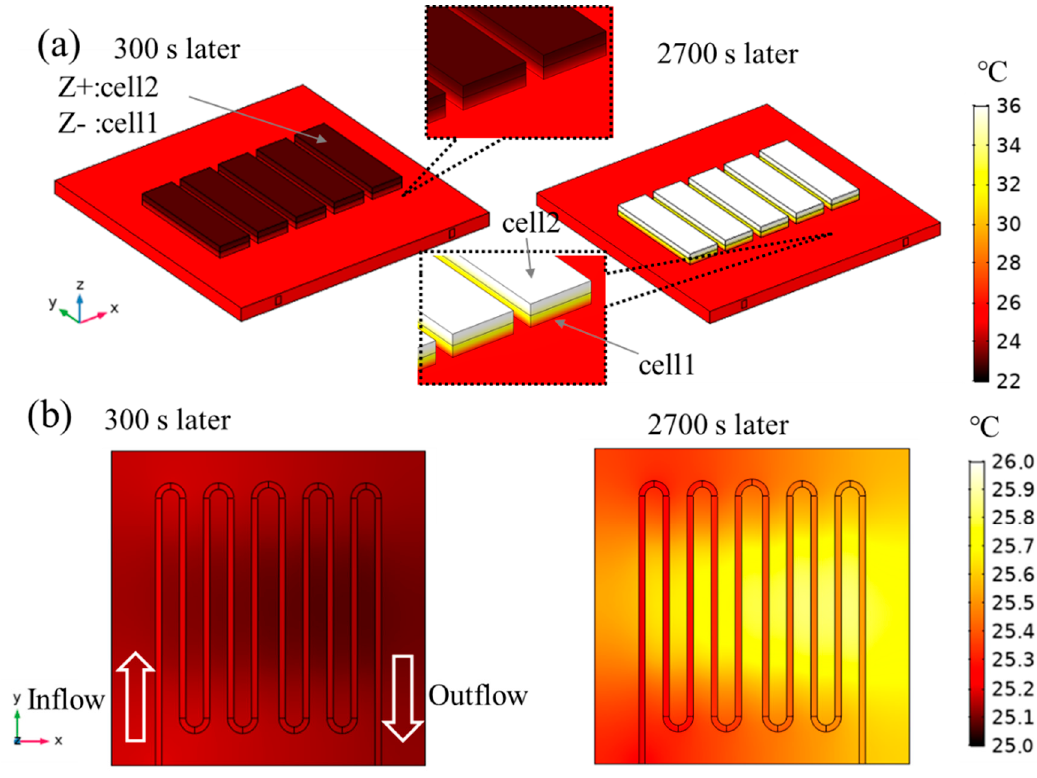
Figure 6. ( a ) The temperature distributions on the surfaces and ( b ) it in the z-directional center cross-section of the flow channel after 300 s and 2700 s in the 3D model under case 2.